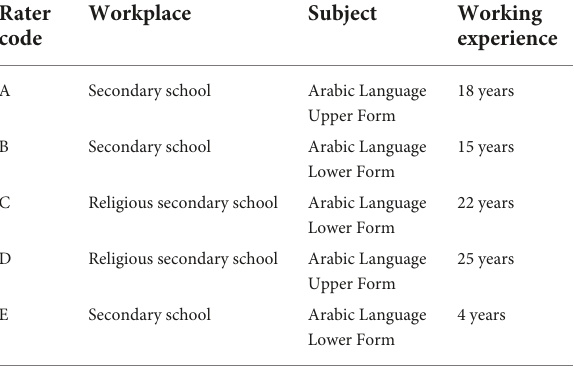
TABLE 1 Summary of rater